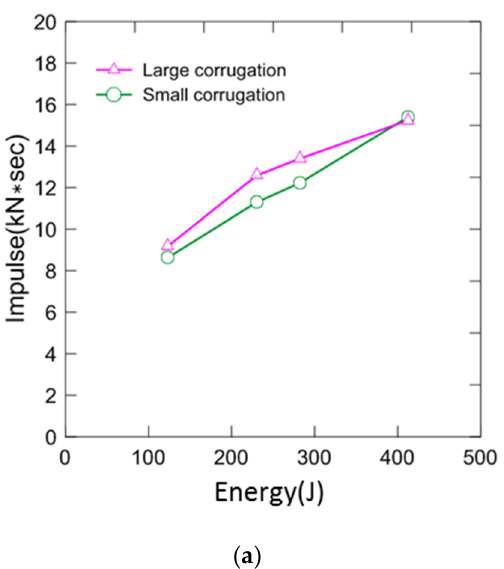
( b ) Figure 4. Reaction force profile of ( a ) large and ( b ) small corrugation in accordance with impact energy.